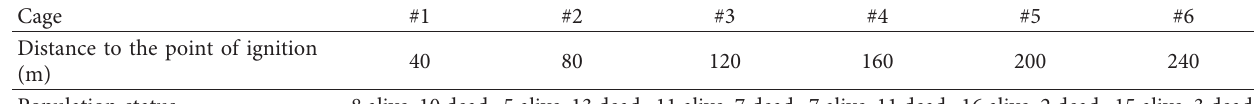
Table 2: Casualty statistics: SD rat populations.